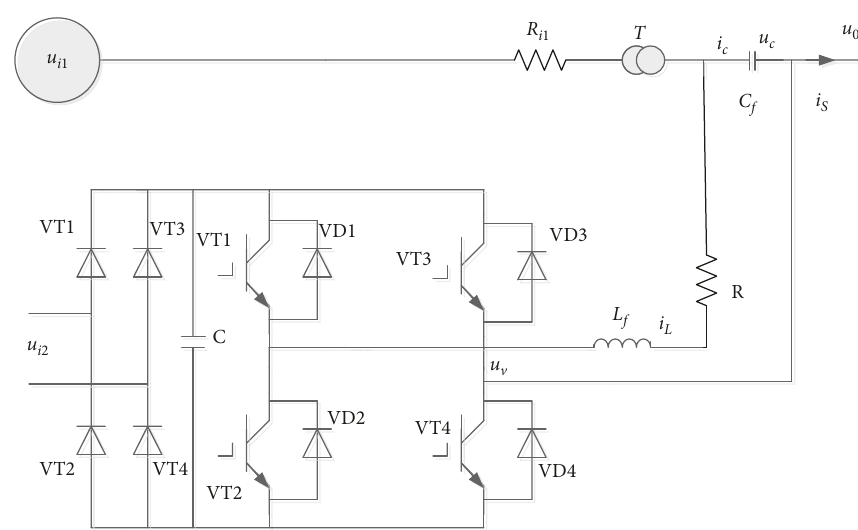
Figure 2: DVR system circuit topology without series transformers.